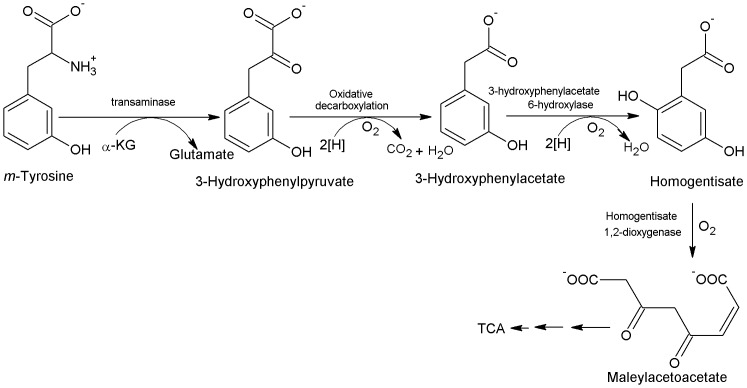
Proposed metabolic pathway for aerobic degradation of m-tyrosine by Bacillus aquimaris SSC5.Based on the data from our study, 3-OH-PPA, 3-OH-PhAc, and HMG are identified as the metabolic intermediates during degradation of m-tyrosine.